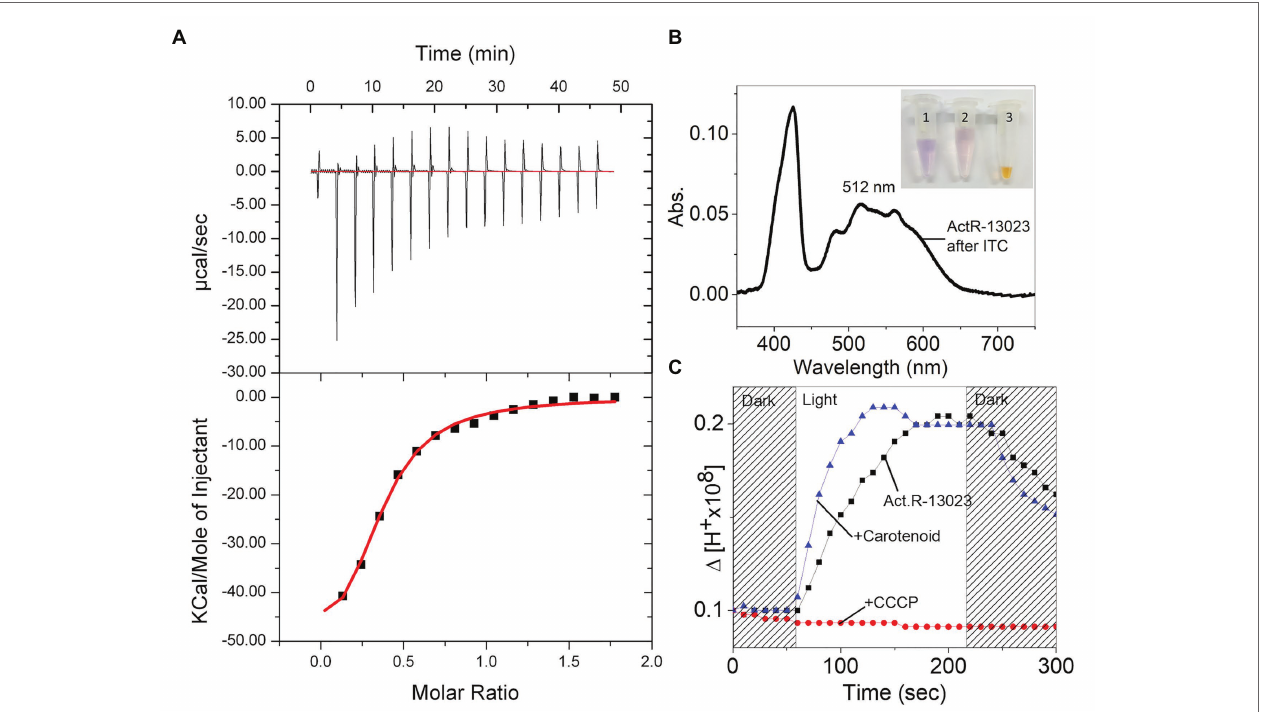
FIGURE 5 | Interaction between ActR-13023 and actinobacterial carotenoid. (A) Isothermal titration calorimetry (ITC) of ActR-13023 and the carotenoid. (B) UV-Vis spectrum of ActR-13023 after ITC experiment; the samples were shown in e-tube (1) purifiedActR-13023, (2) ActR-13023 after ITC experiment with carotenoid, and (3) the carotenoid as the ligand. (C) Comparison of proton pumping in the presence, absence of the carotenoid, and ActR-13023 treated with carbonyl cyanide m-chlorophenyl hydrazine